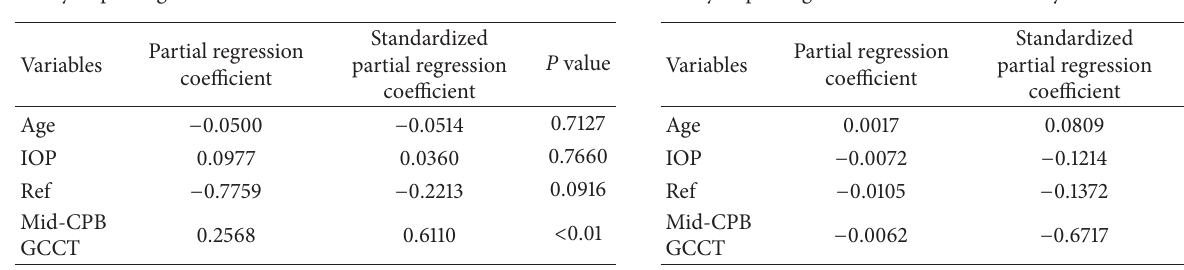
Table 3: Results of multiple regression analysis for factors indepen- dently impacting the central four thresholds.